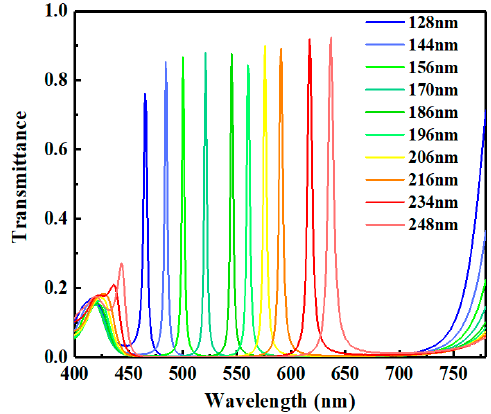
Figure 5. Transmissive spectra of FP cavity with different thicknesses of interlayer.